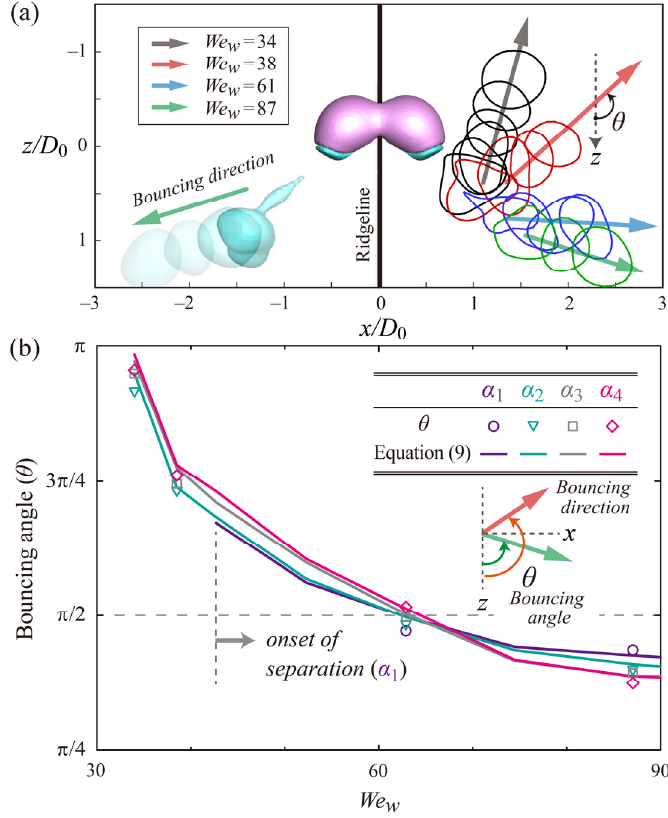
Figure 6. Initial bouncing directions of separated drops as a function of We w and viscosity ratio. ( a ) Sequential images of top-view snapshots in intervals of Δ t = 2 D 0 / U 0 for the estimation of bouncing directions under different We w in the case of the viscosity ratio of α 2 . ( b ) Bouncing angle with respect to +z -direction as a function of We w for four distinct viscosity ratios. Symbols and lines represent θ measured from trajectories and estimated from the characteristic momentum ratios between the horizontal directions during retraction, p z,ret / p x,ret , respectively.